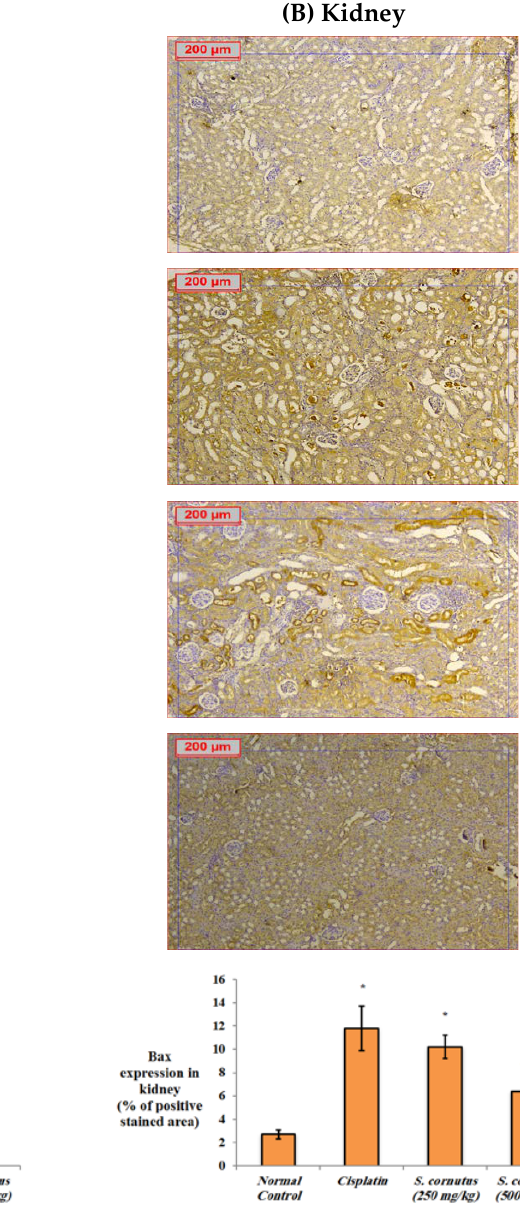
group; # significantly different vs. the cisplatin group; ^ significantly different vs. the S. cornutus (250 mg/kg) group. Differences were considered significant at p < 0.05.